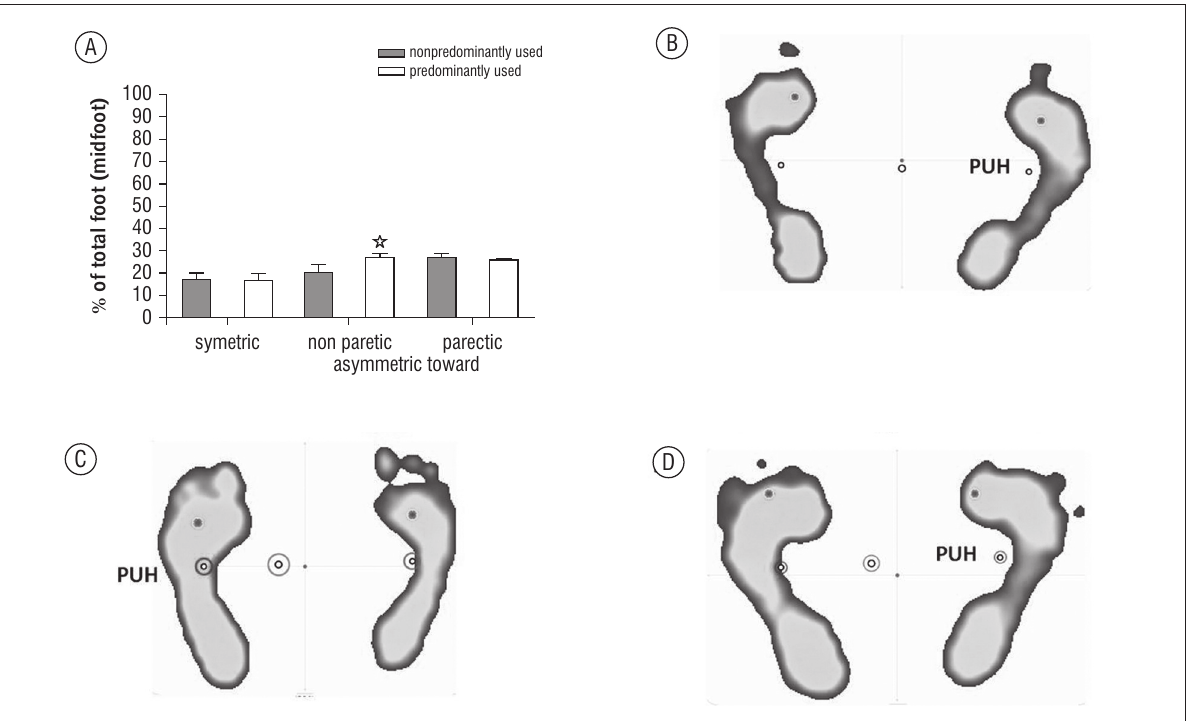
Figure 2 - Bars graph showing Arch Index (mean ± SEM) under non-predominantly (gray bars) and predominantly (whi- te bars) foot used for hemiparesis group classified by weight-bearing distribution type (symmetric, asymme- tric toward non-paretic side and asymmetric toward paretic side). Arch Index is indicated by weight-bearing in percentage of the total foot presented under midfoot (A). Significant difference between Arch Index when compared with symmetric type was pointed by the white star. Images B, C and D are baropodometric re- presentations of the weight-bearing distribution showing, respectively, samples of subjects with symmetry (B), asymmetry toward predominantly used hemibody (PUH – non-paretic side – C), and asymmetry toward non- -predominantly used hemibody (NPUH – paretic side – D). Subjects with hemiparesis represented in the images B, C and D had, respectively, left, right and left